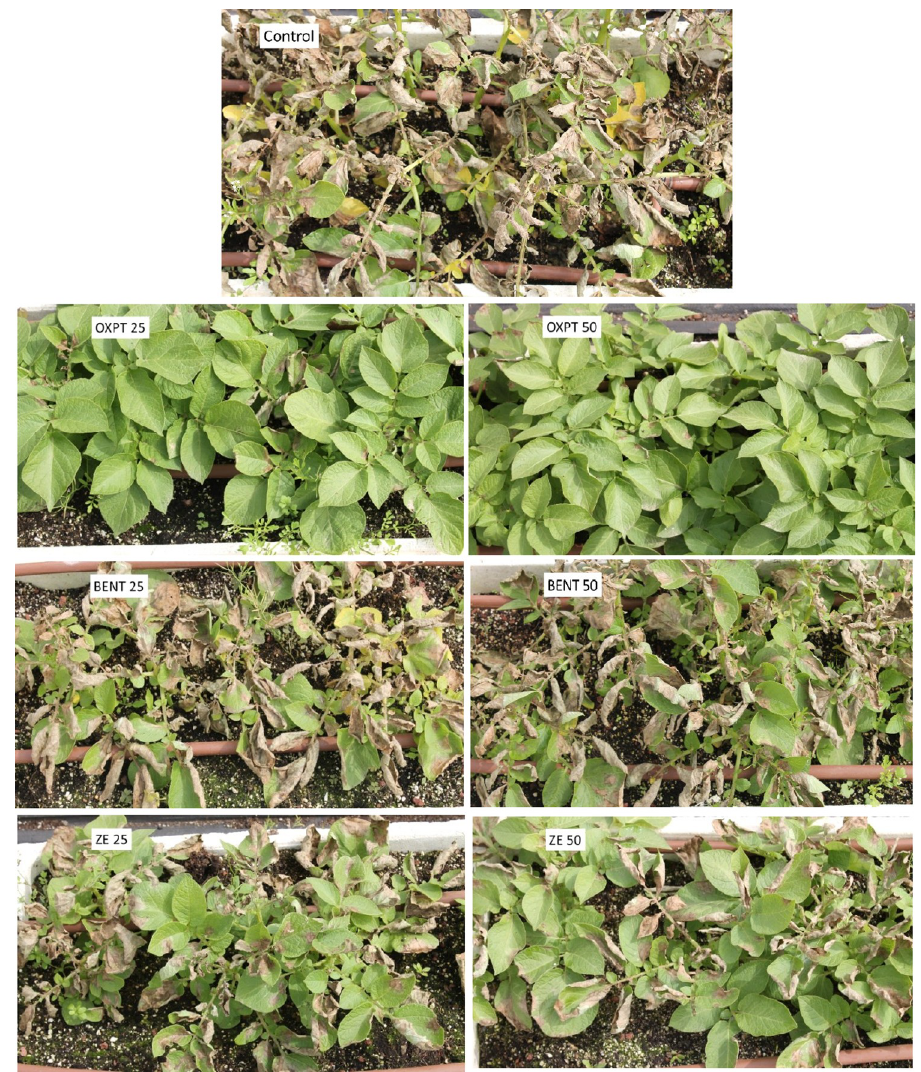
Fig 9. Persistence of fungicidal activity in soil. The appearance of the infected plants at 10 days after inoculation, 128 days after soil drench with OXPT, BENT or ZE at 25 or 50 mg ai per 5 plants in a container. https://doi.org/10.1371/journal.pone.0238148.g009 Table 1. Comparative efficacy of ZE applied to potato crops in the field at Kibbutz Magen, Israel by foliar spray or soil drench. % infected leaf area Days after soil drench ZE Applied Control